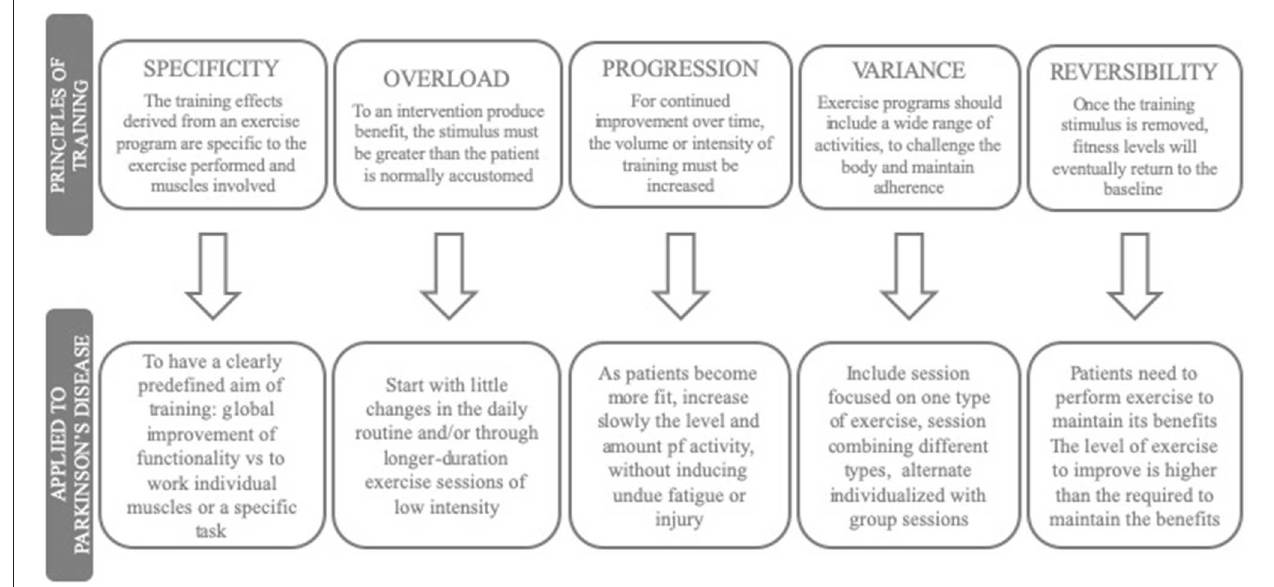
FIGURE 1 | Major aspects of exercise